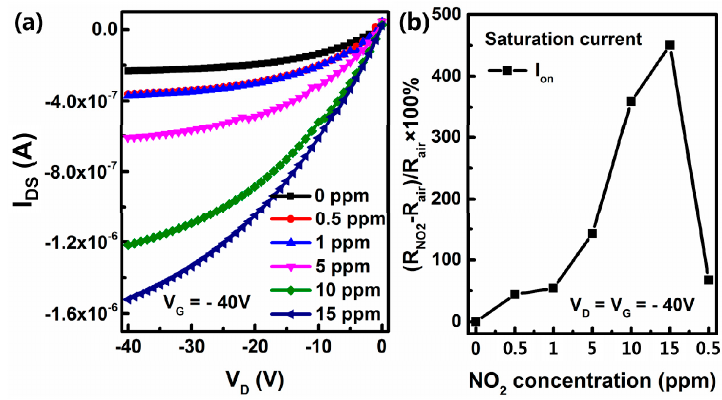
Figure 8. Output curve of devices B ( a ) and percentage variation of I on ( b ) under a specific concentration of NO 2 after stored under ambient for 30 days.